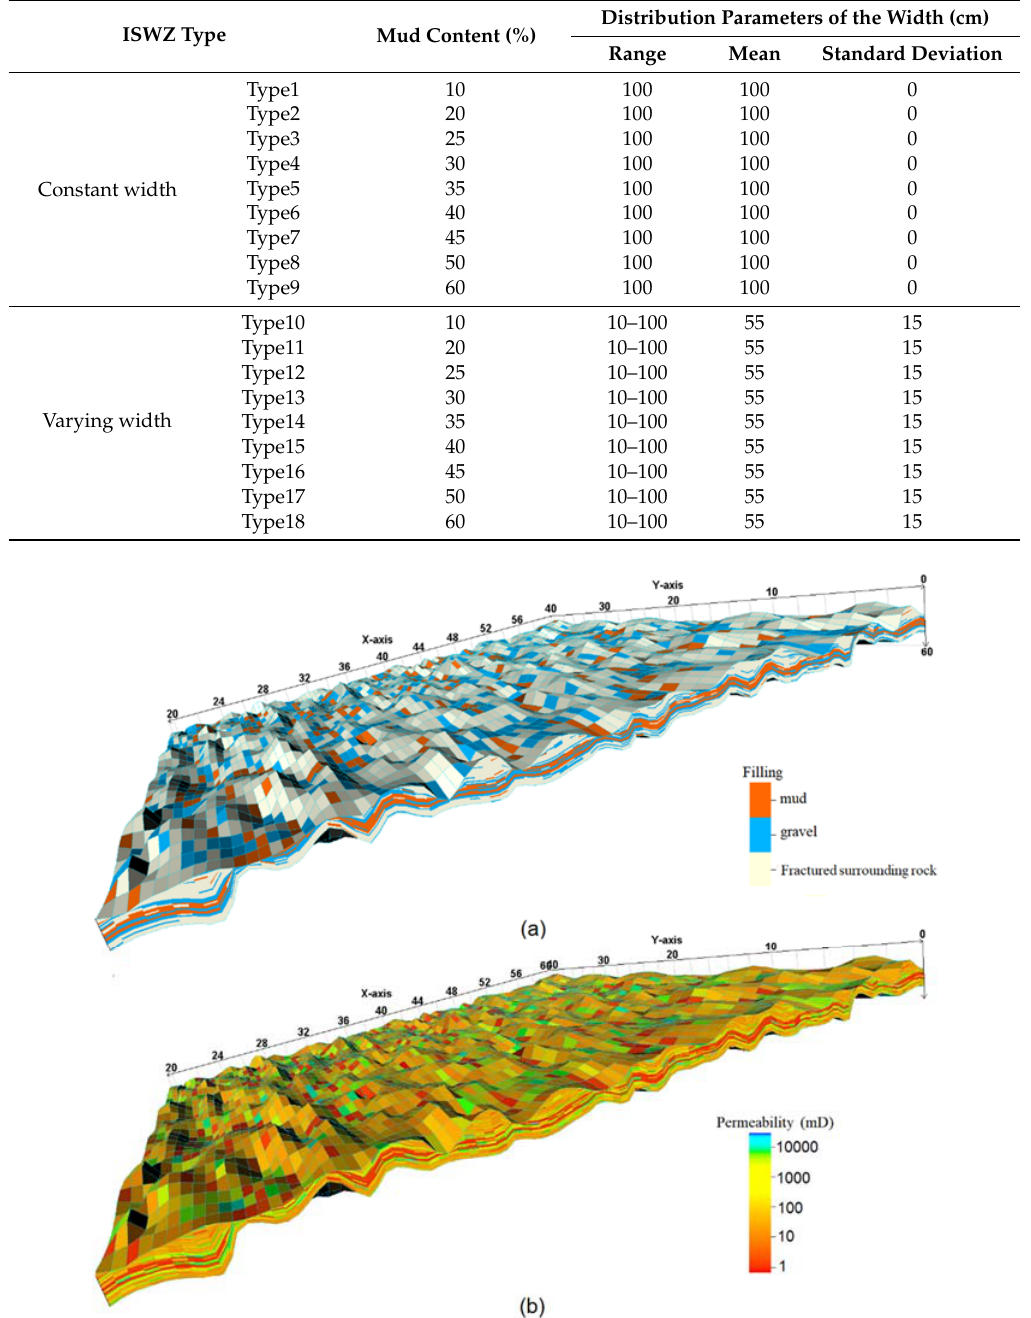
Figure 4. One realization of the numerical model of an ISWZ at the 40 m scale with a mud share of 30%. ( a ) The geometric model with three components represent mud (red), gravel (blue) and fractured surrounding rock (yellow), respectively. ( b ) The corresponding permeability model. The model size in ( a , b ) is 40 × 40 m.